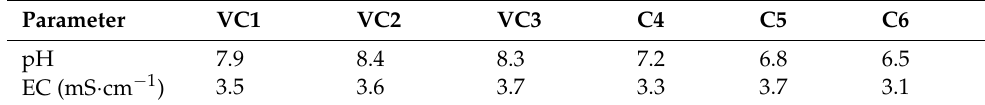
Table 1. The values of pH and EC of analyzed vermicomposts and composts. Parameter